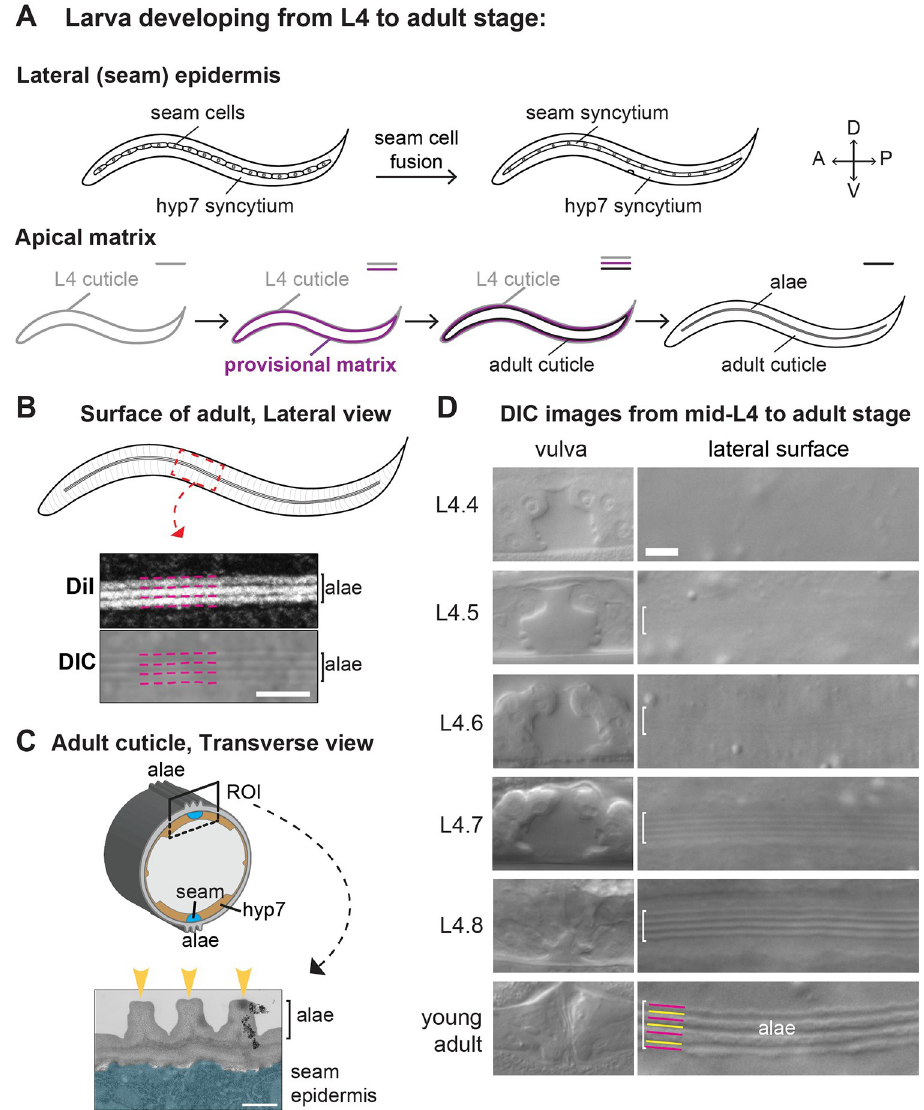
Fig 1. Timeline of adult alae formation. (A) L4-to-Adult development. Top schematics show anatomy of the seam and hyp7 syncytia. Bottom schematics show apical matrices. The provisional matrix (purple) is secreted beneath the L4 cuticle (gray) prior to, or during, synthesis of the new adult cuticle (black). (B) Lateral view of the adult cuticle. Micrographs show adult alae as visualized by DiI staining and DIC. Magenta lines indicate dark bands corresponding to valleys in both the DiI and DIC images. Scale bar: 5 μ m. (C) Transverse view of adult. Cartoon (top) shows how alae are positioned relative to the seam and hyp7 syncytia. Transmission electron micrograph (bottom) shows the three alae ridges (yellow arrowheads). The underlying seam syncytium is false-colored in blue. Scale bar: 500 nm. (D) When viewed by DIC imaging, alae on the developing adult cuticle gradually became visible underneath the L4 cuticle. Brackets indicate regions above seam syncytia where longitudinal ridges could be detected. N2 animals were grown at 20˚C and staged based on vulva tube morphology [31]. Alae were detected in 0/24 L4.4, 3/9 L4.5, 11/13 L4.6, 24/26 L4.7, 15/15 L4.8, and 16/16 adults imaged. When detected at L4.5 or L4.6, the alae were very subtle, as shown. Scale bars: 5 μ m. cuticle formation occurs in the context of actomyosin-driven seam cell apical constriction, which elongates the embryo and narrows the entire body shape [23,24]. Similarly, dauer larvae are radially-constricted compared to the preceding larval stage [16,19,22]. Cuticulin mutants